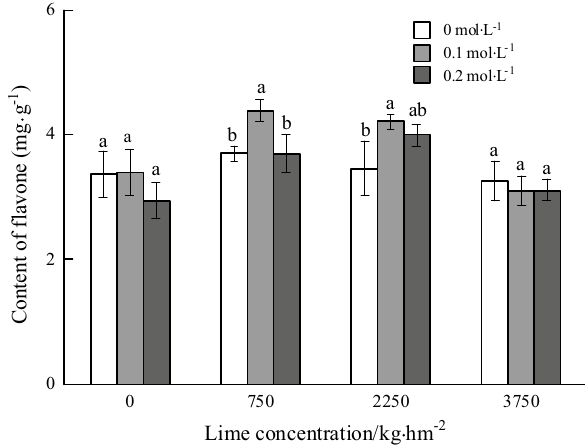
Figure 5. Effects of foliar spraying of oxalate on the contents of flavonoids in roots of Panax notoginseng under Cd stress.